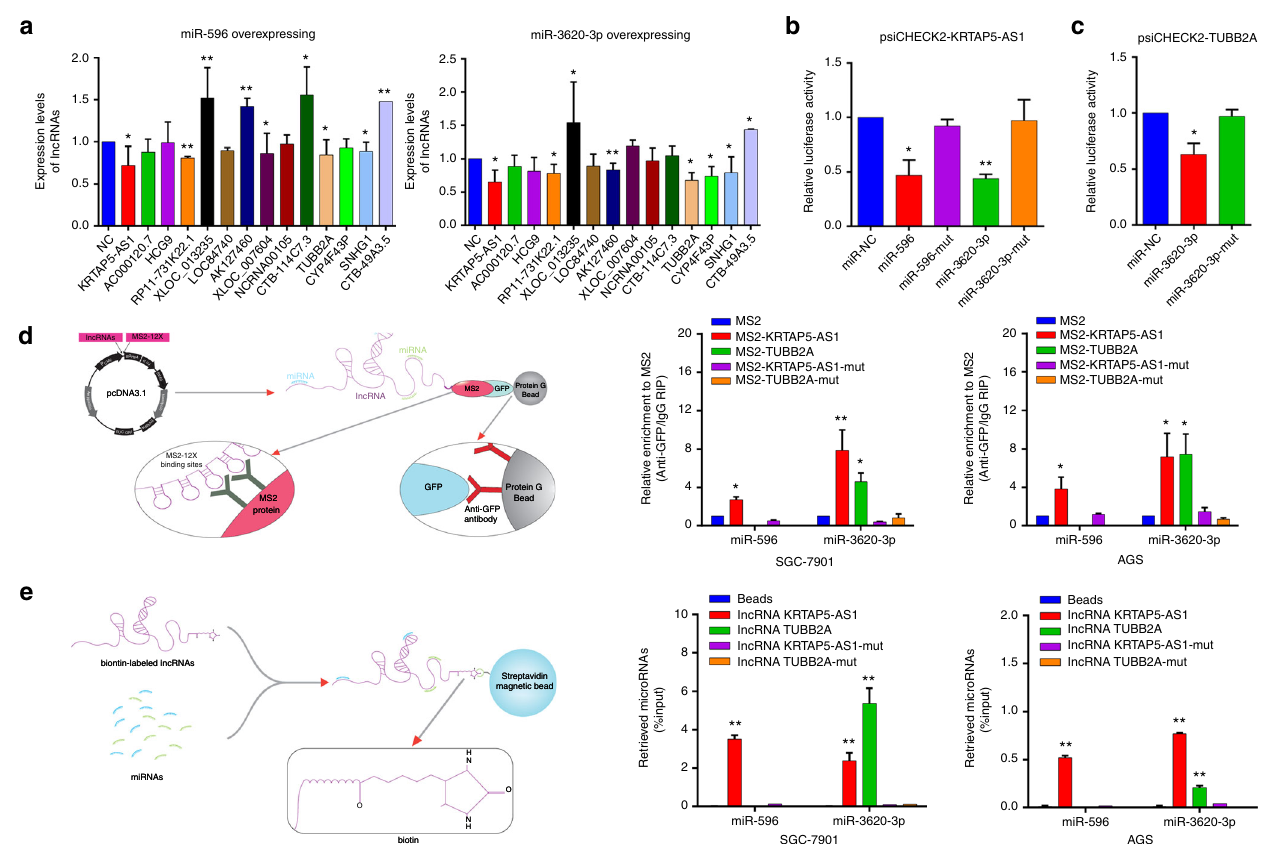
Fig. 4 LncRNAs can crosstalk with miRNAs through direct binding. a Relative expression of lncRNAs in GC cells treated with mimics of miR-596 or miR-3620-3p were measured by real-time PCR. b Luciferase activity in GC cells co-transfected with luciferase reporter containing lncRNA-KRTAP5-AS1 and the mimics of miR-596, miR-3620-3p or mutant. Data are presented as the relative ratio of renilla luciferase activity and fi re fl y luciferase activity. c Luciferase activity in GC cells co-transfected with luciferase reporter containing lncRNA-TUBB2A and the mimics of miR-3620-3p or mutant. Data are presented as the relative ratio of renilla luciferase activity and fi re fl y luciferase activity. d The schematic diagram and real-time PCR results of the MS2-RIP method used to identify the binding between lncRNAs and miRNAs in both SGC-7901 and AGS cells. e The schematic diagram of the RNA pull down method used to identify the binding between lncRNAs and miRNAs in both SGC-7901 and AGS cells. GC cell lysates were incubated with biotin- labeled lncRNA-KRTAP5-AS1, lncRNA-TUBB2A, lncRNA-KRTAP5-AS1-mut, and lncRNA-TUBB2A-mut. MiRNA real-time PCR was performed after pull down process. Data are shown as mean ± s.d., n = 3. The data statistical signi fi cance is assessed by Student ’ s t-test. * P < 0.05, ** P <